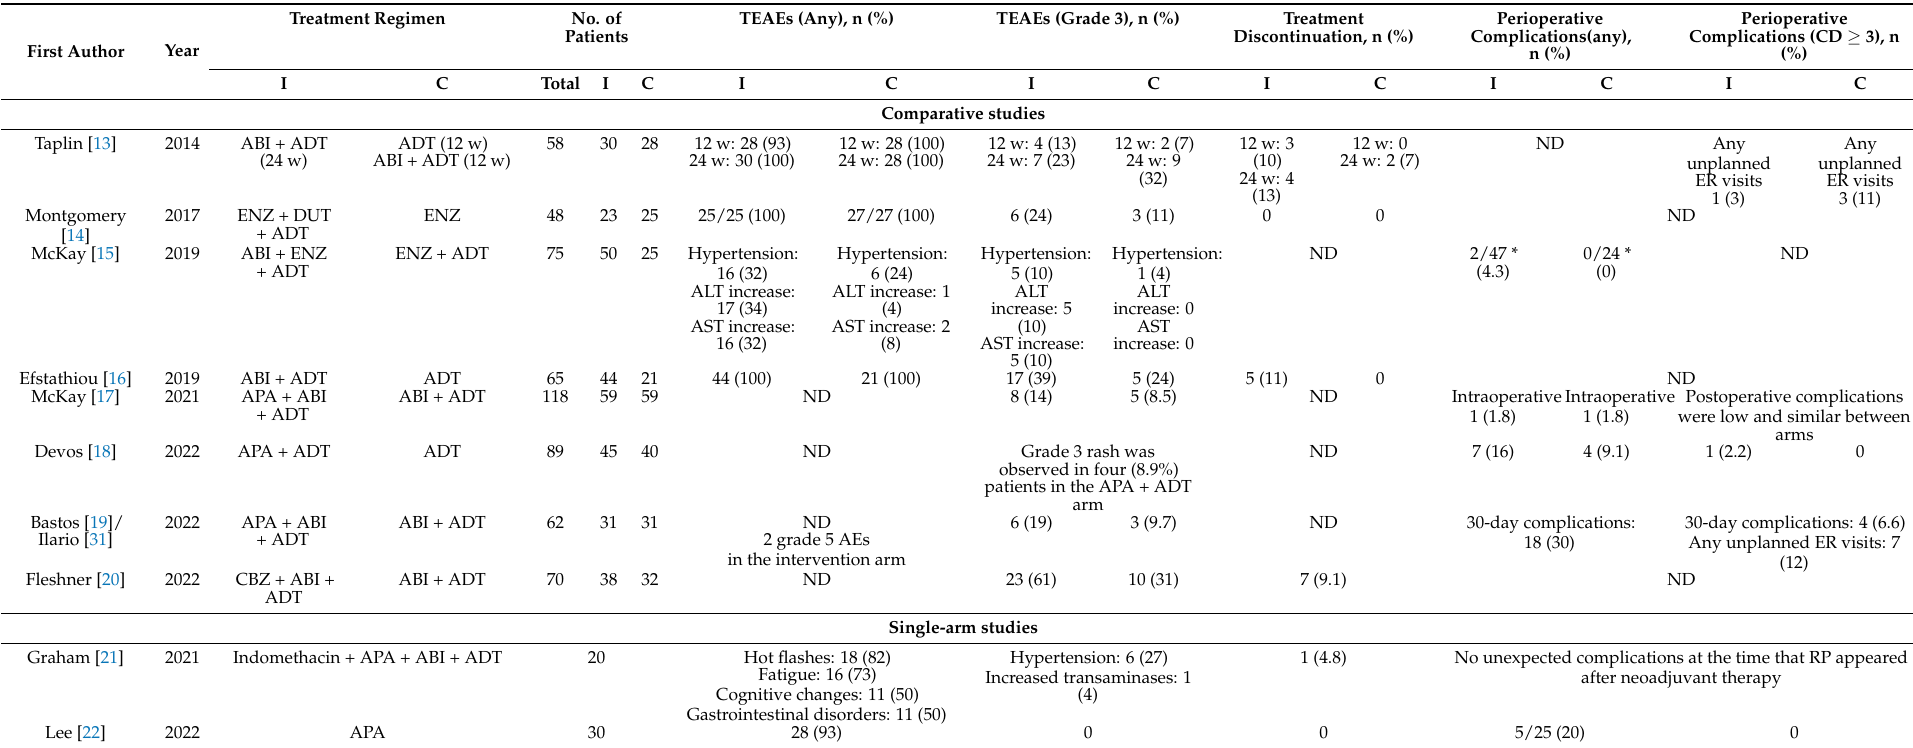
Table 3. Treatment-emergent adverse events and perioperative complications of eligible